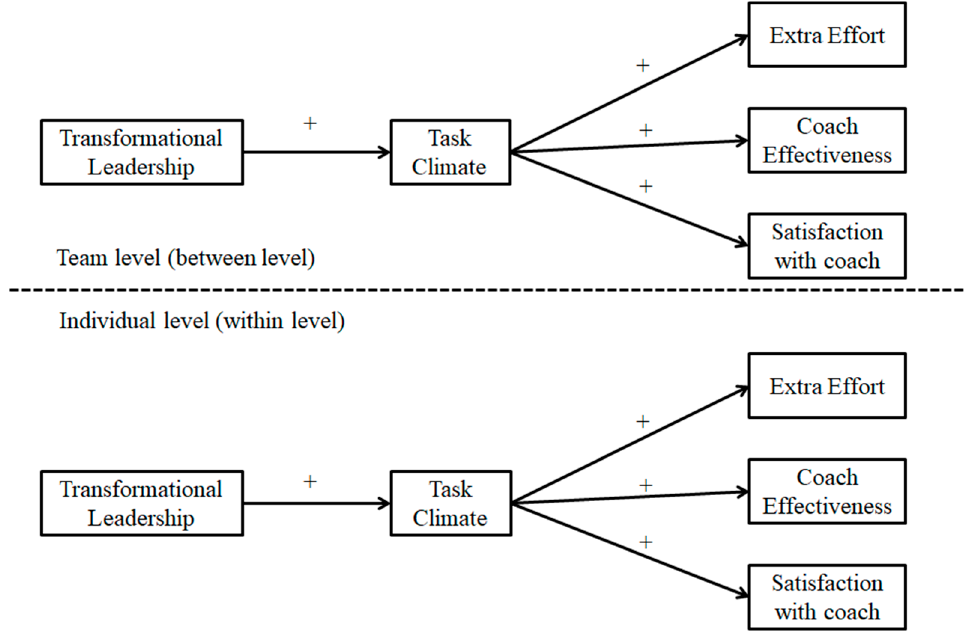
Figure 1. Hypothesized multilevel SEM model (M1) of the associations between transformational leadership style, task-involving climate, and outcome criteria.